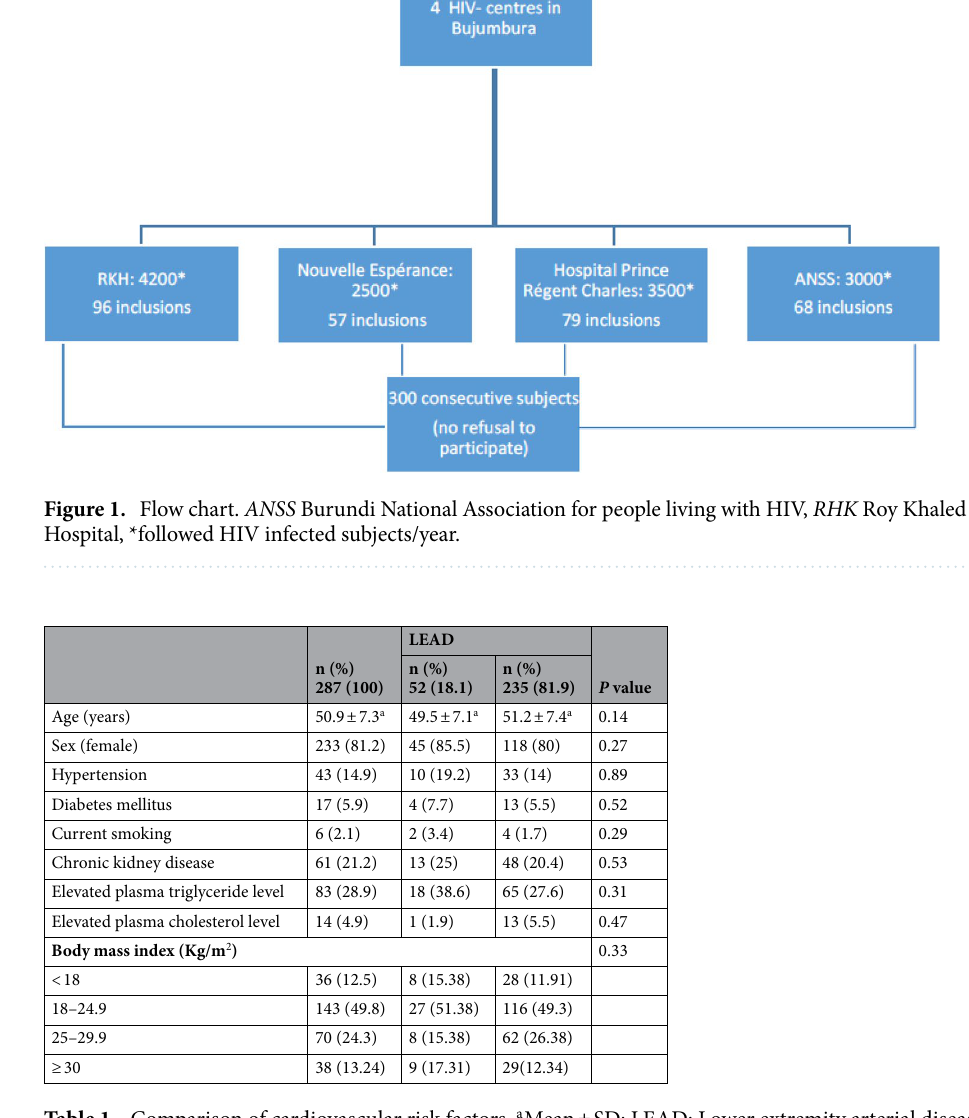
Table 1. Comparison of cardiovascular risk factors. a Mean ± SD; LEAD: Lower extremity arterial disease, Elevated cholesterol level > 5.7 mmol/l, Elevated plasma triglyceride > 1.72 mmol/l.